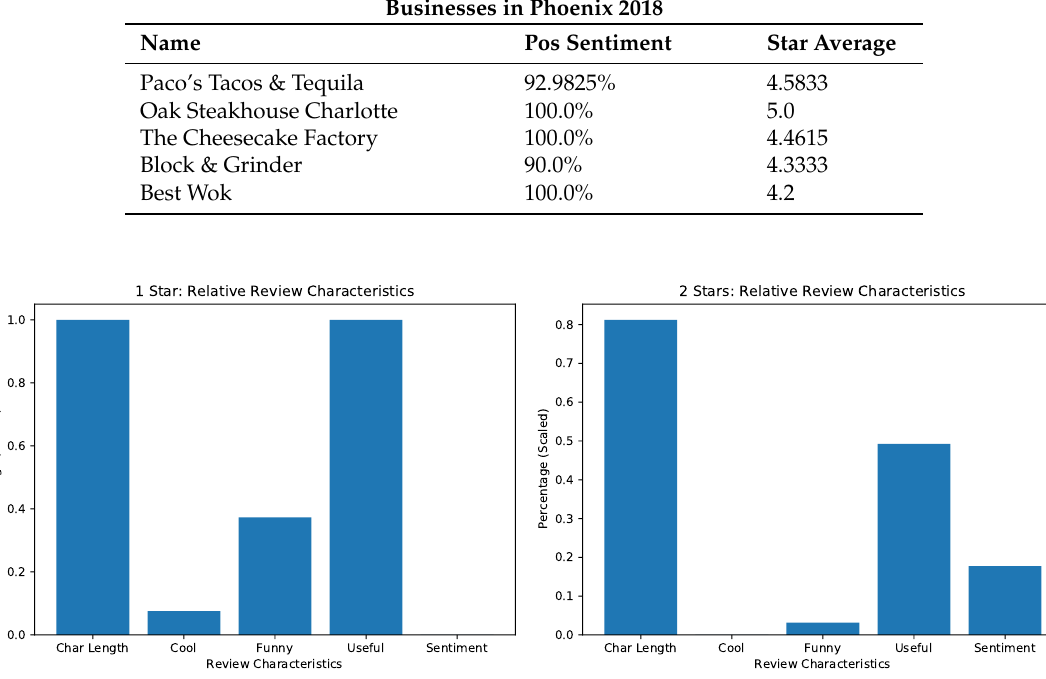
Figure A7. Results from analysis “Review Trends in Phoenix 2018”. Displayed are relative characteristics of 1 and 2 star reviews over reviews of restaurants in Phoenix 2018.